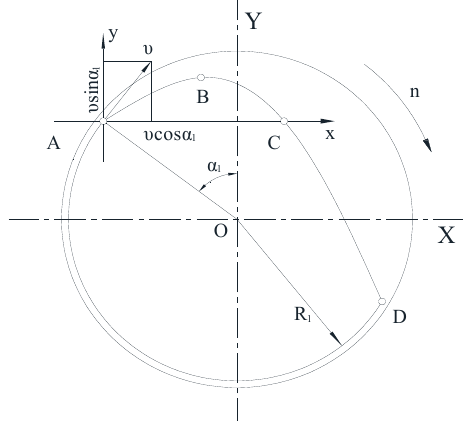
Figure 2. The trajectory of the outermost medium in the mill.